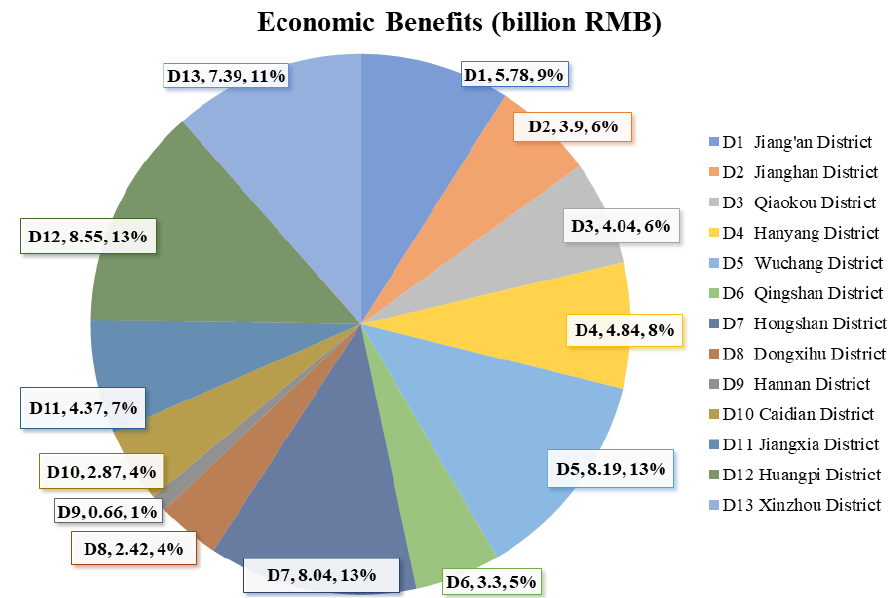
Figure 2. Economic benefits of PM 2.5 concentration reduction in Wuhan between 2013 and 2017 (billion RMB). ( D1 ), 5.78, 9% means that the economic benefit of Jiang’an District was 5.78 billion RMB, accounting for 9% of the total economic benefits of Wuhan.